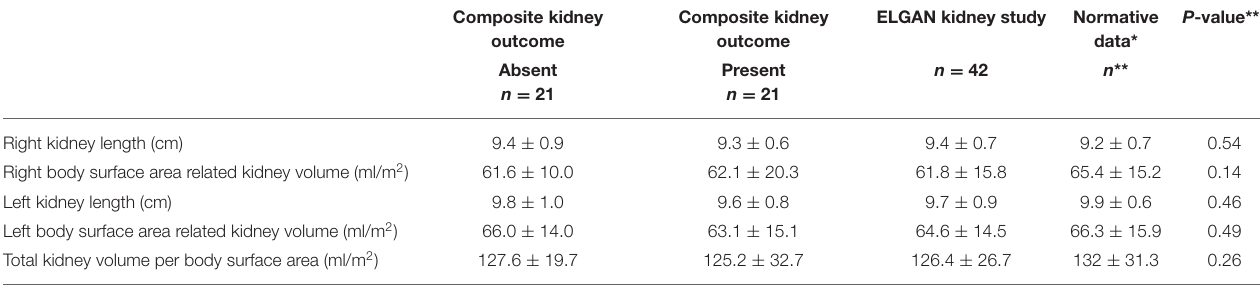
TABLE 2 | Mean (SD) renal ultrasound measurements from adolescent participants of the UNC-CH ELGAN study who participated in a kidney study visit (2017–2019), compared to mean (SD) normative age-matched kidney ultrasound data * . Composite kidney